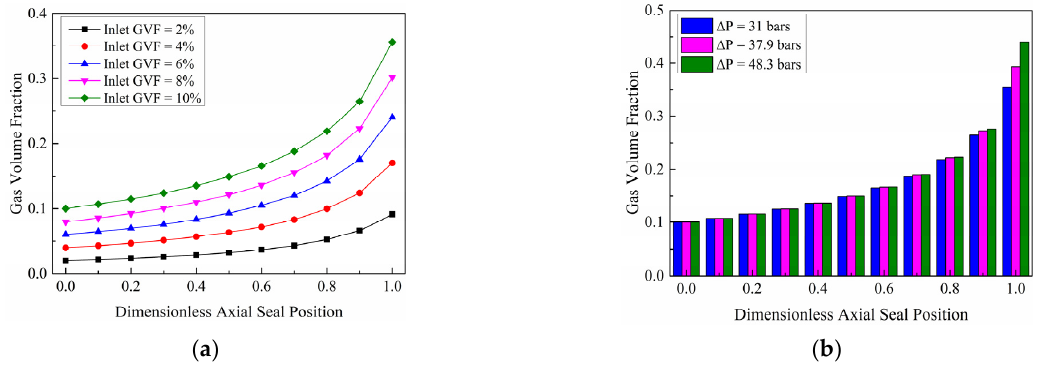
Figure 4. GVF distribution characteristics along the axial direction under different operating conditions. ( a ) GVF under different inlet GVFs for Δ P = 31 bars, ( b ) GVF under different pressure differences for inlet GVF = 10%.